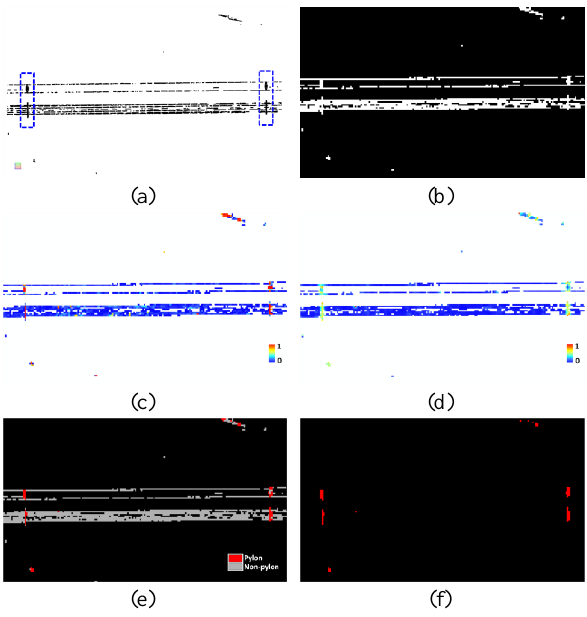
Figure 3. Pylon segmentation; (a) line segments (blue boxes: pylons), (b) binary image from (a), (c) maximum orientation variation [0,1], (d) orientation parallelism [0,1], (e) pylon classification (RF), and (f) pylon